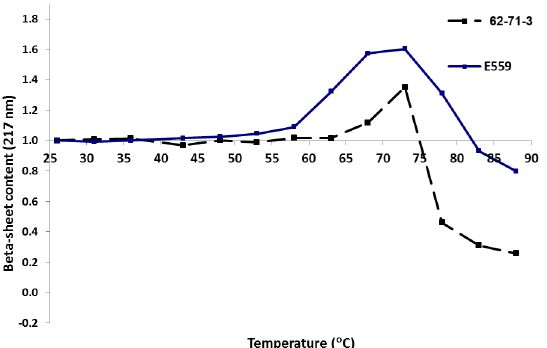
Fig 7. Changes in the β -sheets content of 62-71-3 (black) and E559 (blue) mAbs with increasing temperature.